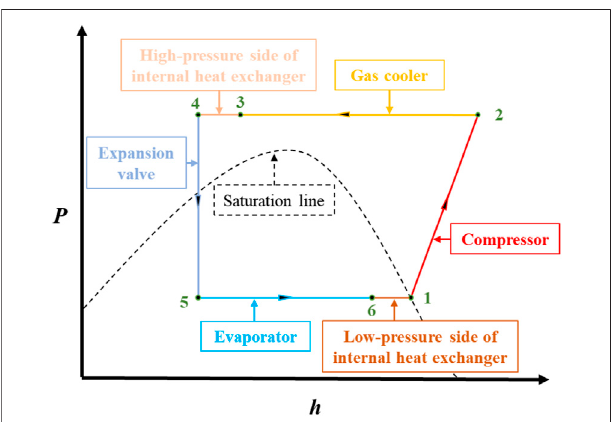
FIGURE 3 | Pressure-enthalpy diagram of transcritical CO 2 heat pump